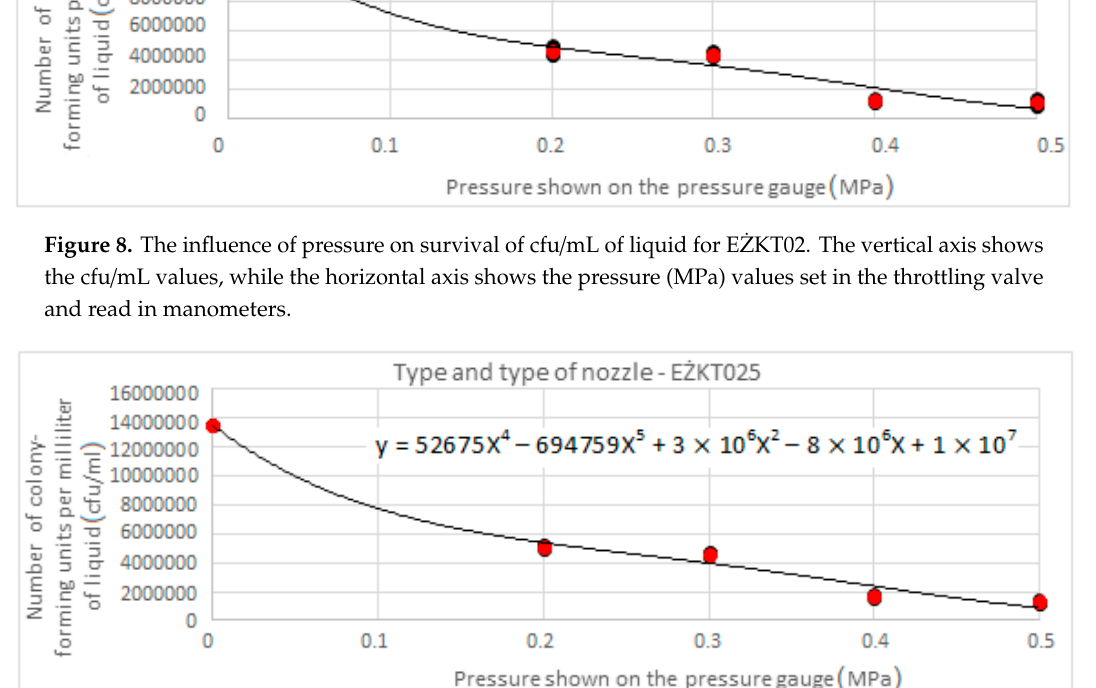
Figure 9. The influence of pressure on survival of cfu/mL of liquid for E Ż KT025.